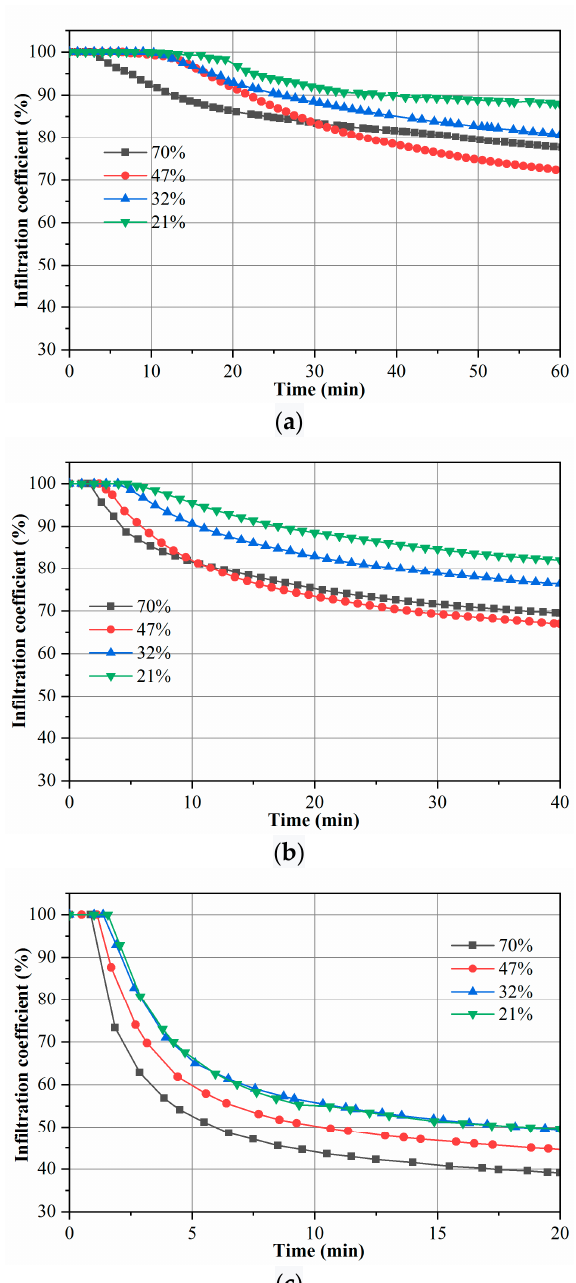
Figure 9. Infiltration coefficient as a function of time of each slope under different rainfall events: ( a ) Dry run; ( b ) Moderate run; ( c ) Wet run.